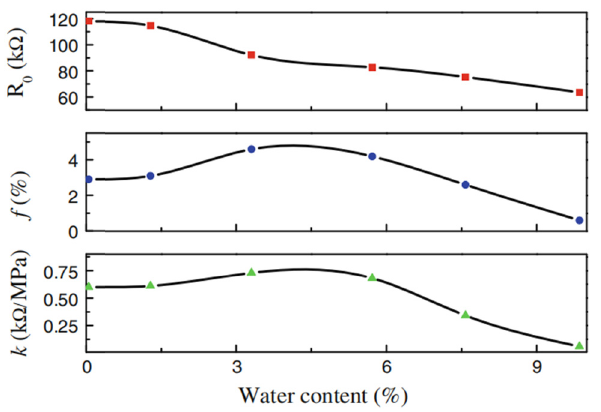
Figure 4: Initial resistivity R 0 , maximum resistance amplitude change f , and piezoresistive sensitivity k of CNTCS with di ff erent water content [ 41 ]